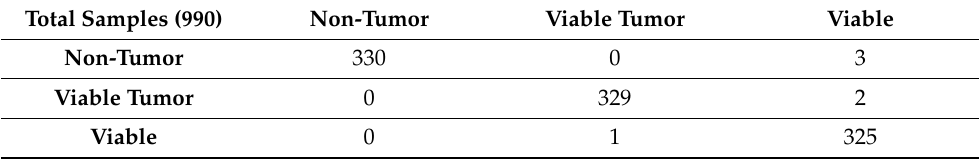
Table 5. Testing confusion matrix of RMSProp empowered with transfer learning.